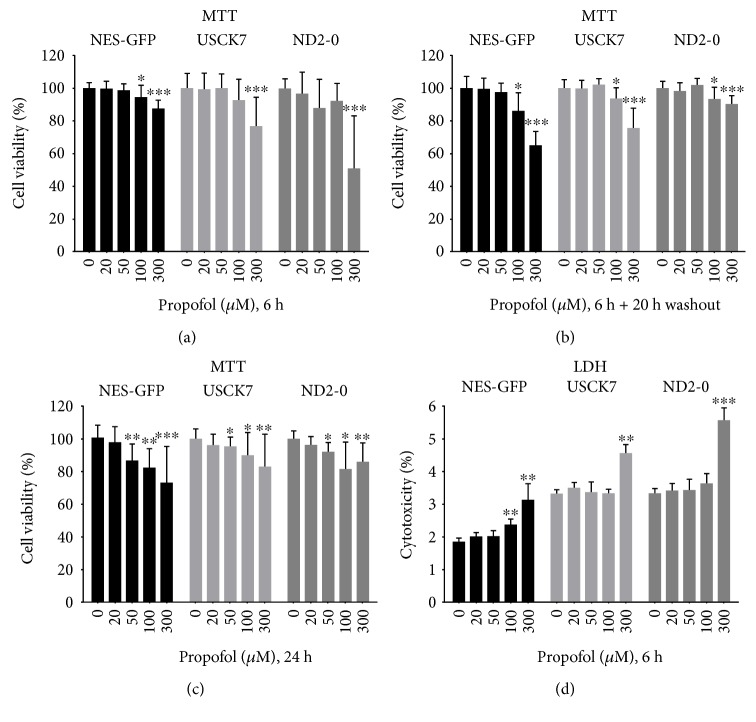
High-concentration propofol treatment exerts toxicity to NPCs. NPCs derived from three hiPSC lines were exposed to propofol at different concentrations (0, 20, 50, 100, and 300 μM). MTT assays showed high-concentration propofol-reduced NPCs viability after the 6 h (a) or 24 h (c) treatment, or 6 h treatment followed by 20 h washout (b). Data from LDH assays further showed that propofol at a high concentration reduced the number of NPCs (d). Data at each concentration were analyzed by unpaired t-tests. For MTT assays, data were expressed as a percentage of viable cells of the treatment compared to the untreated (0 μM propofol) group (mean ± SD). For LDH assays, data were expressed as a percentage of positive control (mean ± SD), compared to 0 μM propofol exposure group. For both assays, 5 wells per treatment condition were examined. Each experiment was repeated for at least three times. ∗p < 0.05; ∗∗p < 0.01; ∗∗∗p < 0.001.